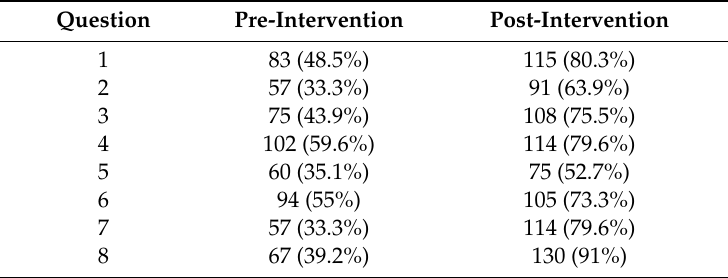
Table 1. Correct answers (proportion) to each of the 8 questions of the questionnaire (pre-intervention compared to post-intervention).